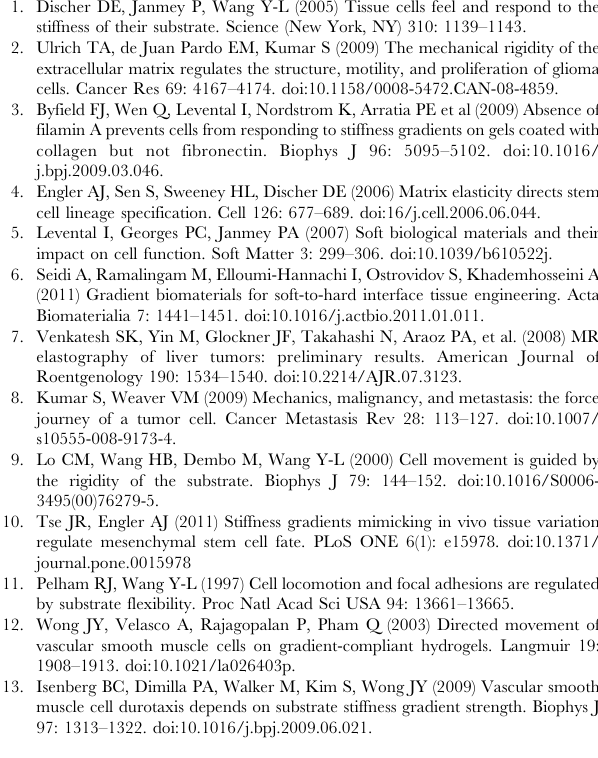
Figure S5 Hydrogels treated with Sulfo-SANPAH incor- porate substantially more fibronectin (FN) than untreat- ed ones. Fluorescence intensity profile along a gradient hydrogel using the Sulfo-SANPAH protocol described in the Methods Section (blue squares), incubation with fibronectin in absence of sulfo-SANPAH (red squares), or incubation with BSA alone. Error bars represent SE of 3 replicates. (TIF) Figure S6 Stiffness gradient fabrication schematic. (A) The acrylamide/bis-acrylamide/Irgacure solution is placed be- tween 2 coverslips and supported on the top of a 4 6 objective by means of a holder. The mask is attached to a microscope stage that allows precise control of the mask speed. The sample is illuminated by a UV bench lamp placed on the top of the setup. (B) The holder is an empty cylinder that allows one to image the solution as the mask progressively uncovers the polymerizing solution.